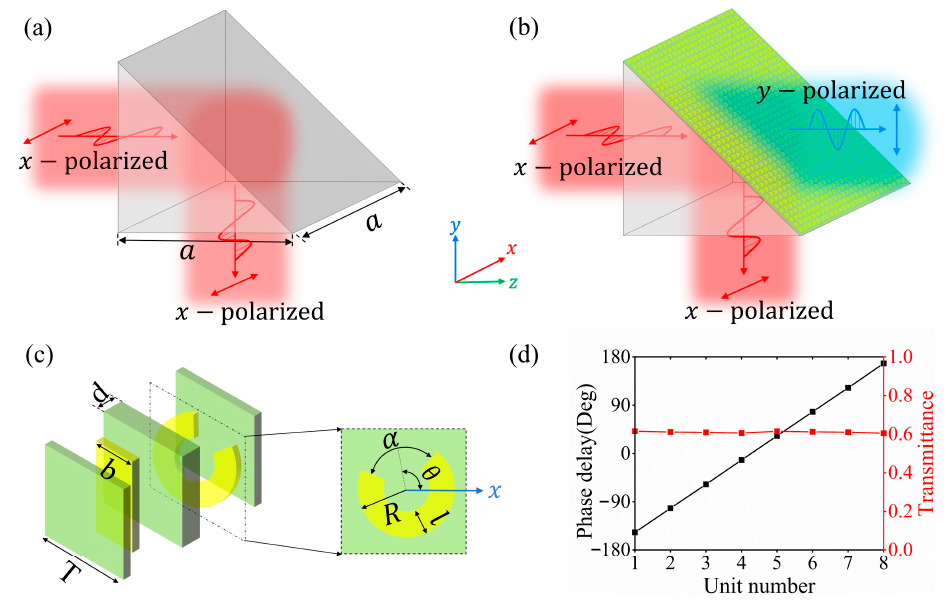
Figure 1. Schematic of an HDPE prism ( a ) Without and ( b ) With a metasurface attached for the control of THz beams. ( c ) Structure of a unit cell in the metasurface. ( d ) Phase delay and transmittance of selected eight cells for b = 0.4 mm, R = 0.34 mm, and T = 0.8 mm. The target frequency is f = 0.14 THz.